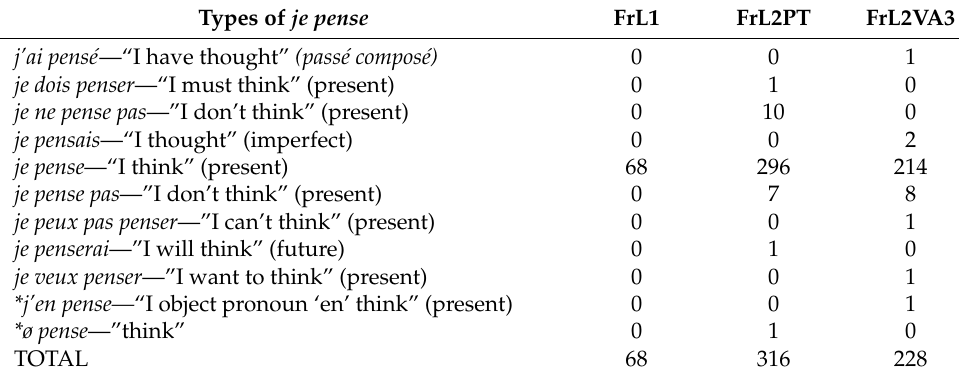
Table 4. Type of je pense expressions in the